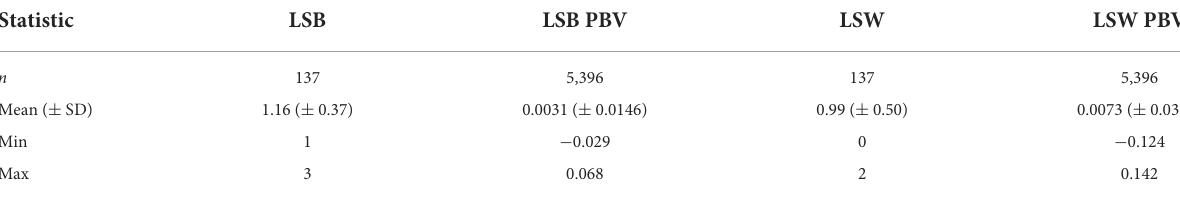
TABLE 1 Descriptive statistics and estimated breeding values for litter size at birth and litter size at weaning in the Markhoz goat. Statistic